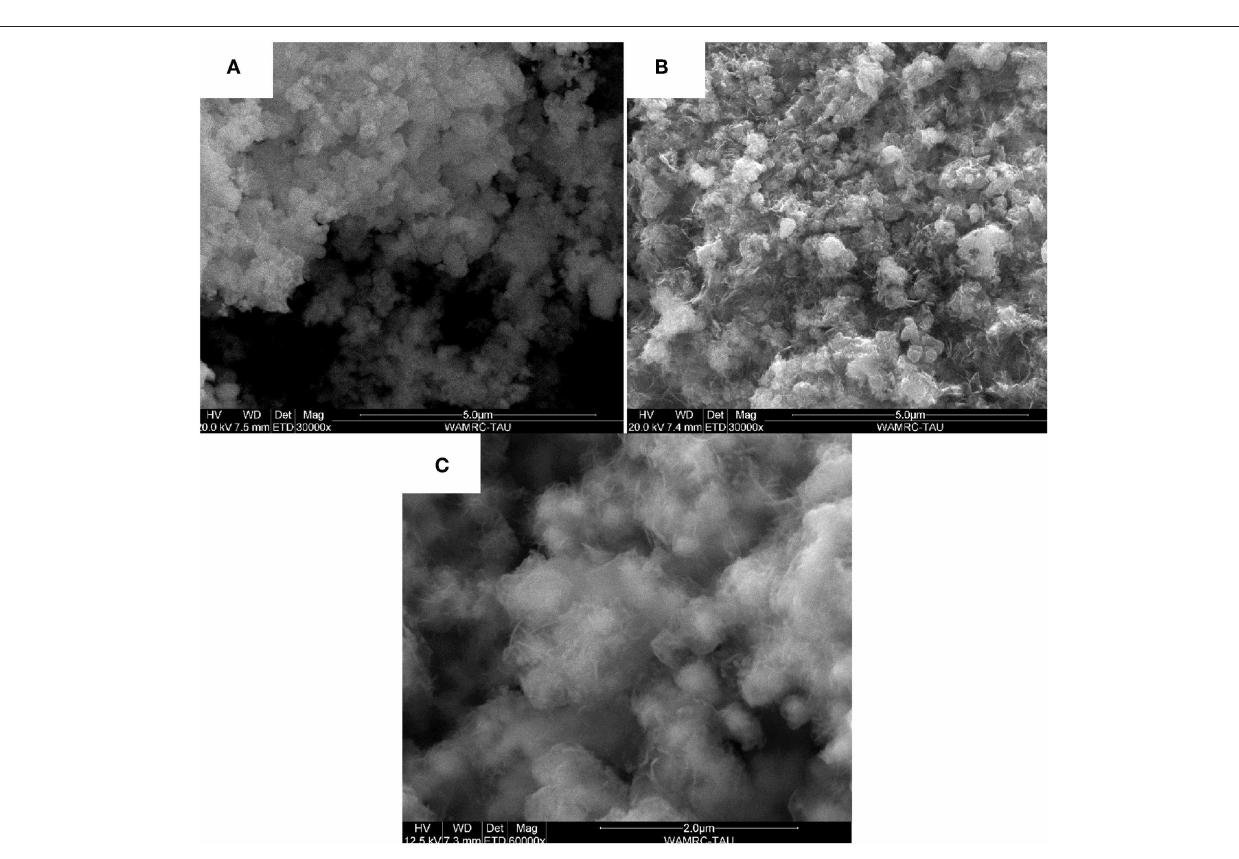
Frontiers in Materials |